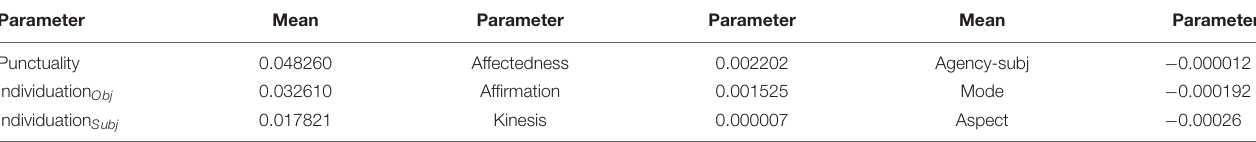
TABLE 3 | Mean weights of the transitivity parameters.